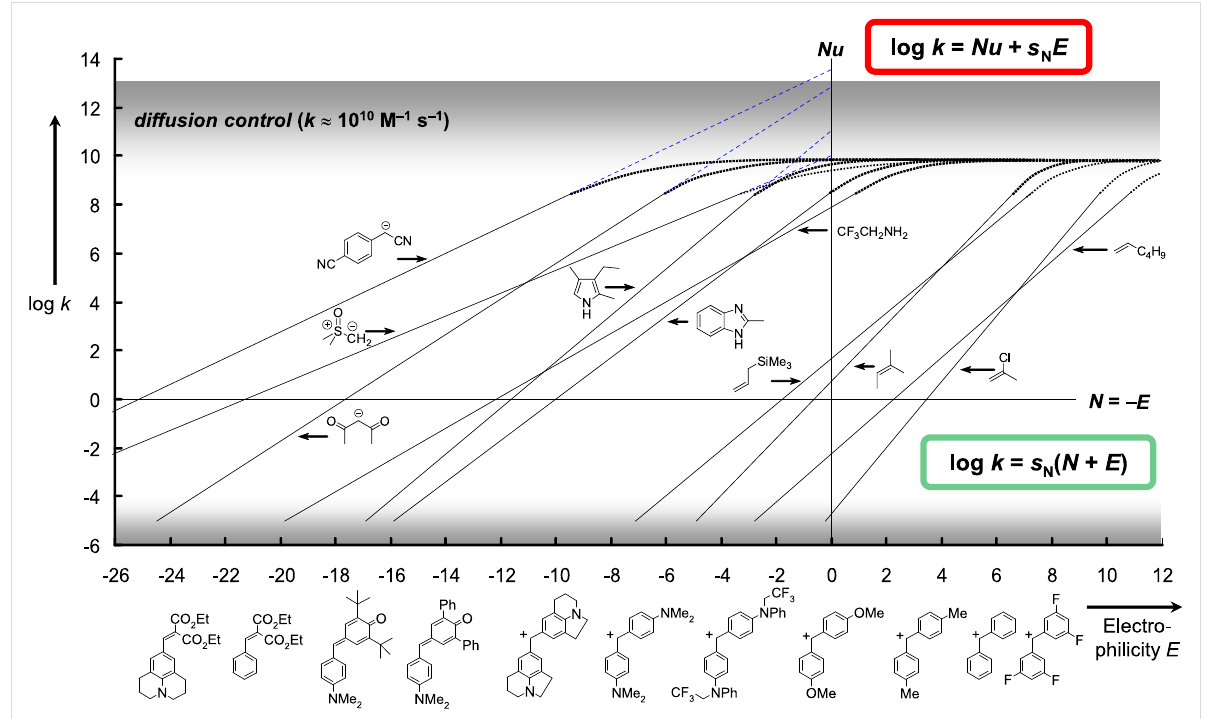
Figure 1: Second-order rate constants for reactions of electrophiles with